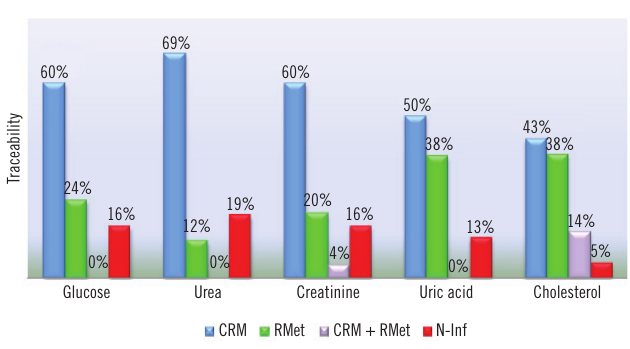
figurE − Traceability of the analytical systems reported by the laboratories participating in the proficiency testing program of ControlLab, for determinations of glucose, urea, creatinine, uric acid, and cholesterol, during 2012 and 2013 CRM: certified reference material; RMet: reference method; N-Info: no information on the use of CRM or